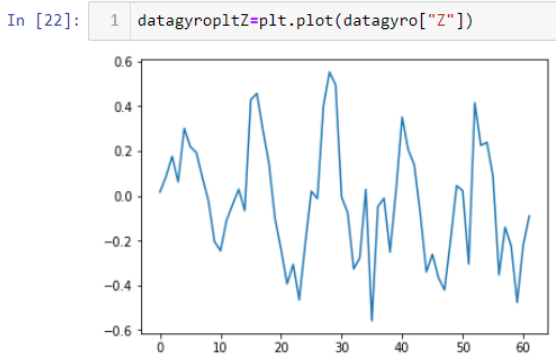
Figure 46. Gyroscope z -axis data for point_1.